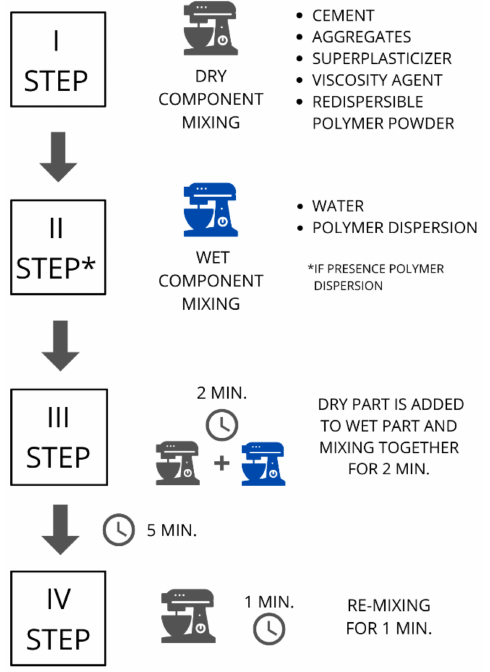
Figure 2. The scheme of samples formation.